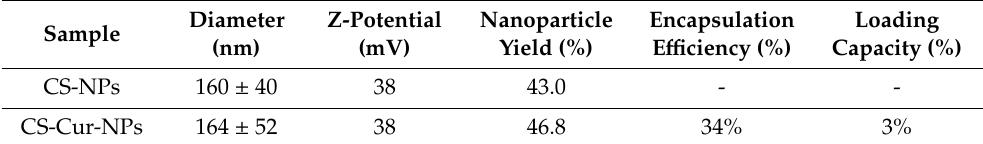
Table 1. Characteristics of the chitosan nanoparticles (CS-NPs) and Cur-loaded chitosan nanoparticles (CS-Cur-NPs).